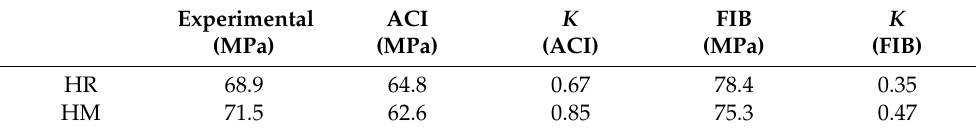
Table 5. Comparison between the experimental and analytical values for reinforced test